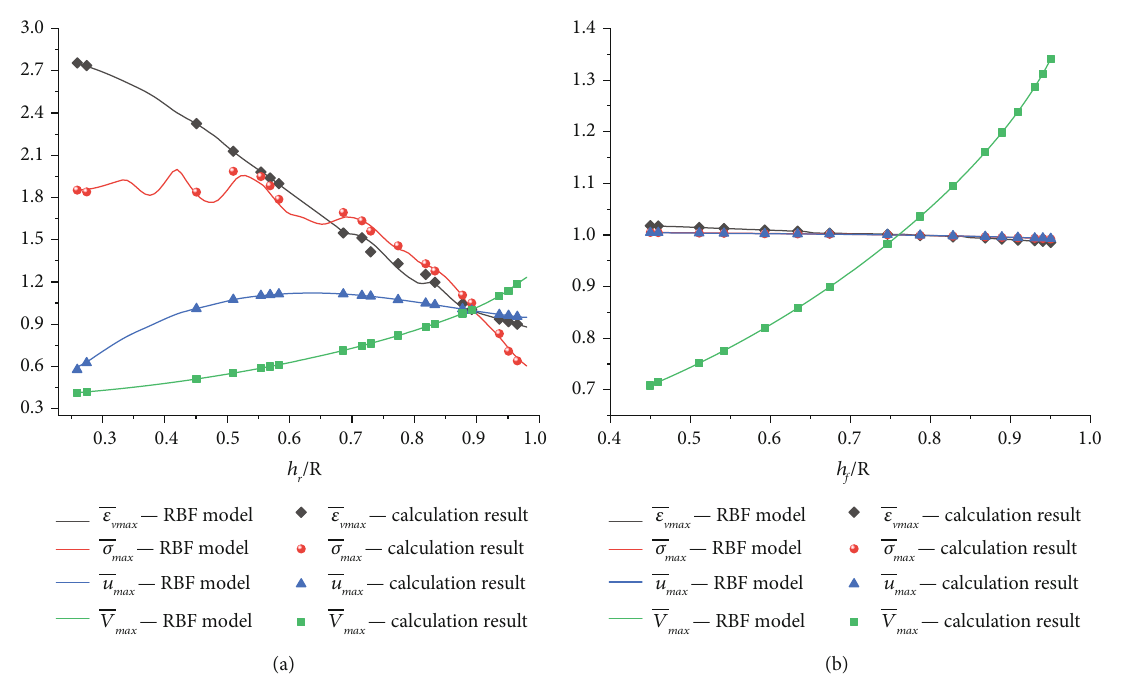
Figure 4: Comparison chart between the RBF model and the calculation